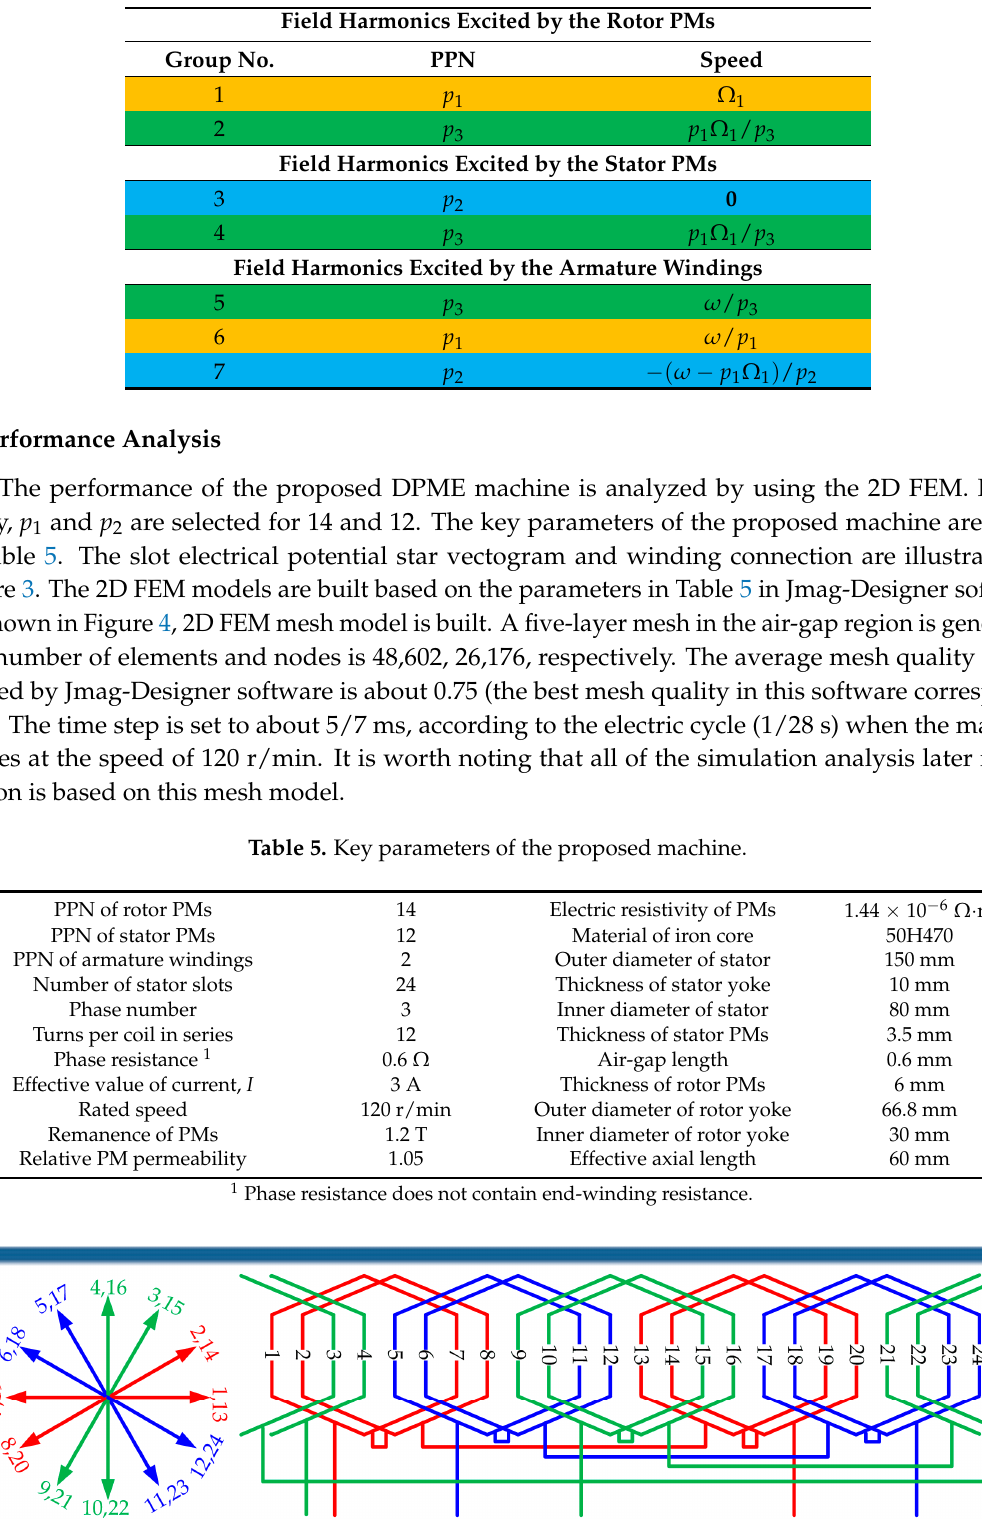
Table 4. The effective field harmonics.